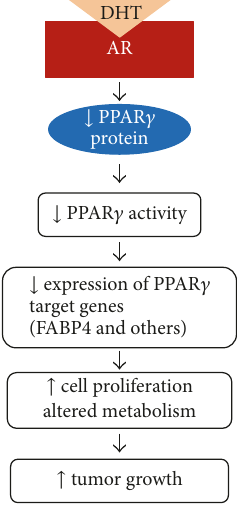
Figure 2: AR regulates PPAR 𝛾 signaling in human prostate can- cers. Data from our laboratory suggest that androgen-induced AR activation produces a net decrease in PPAR 𝛾 protein and PPAR 𝛾 activity in AR-positive castration-sensitive (VCaP) and castration- resistant (C4-2) prostate cancer cells. These decreases in PPAR 𝛾 transcriptional activity result in reduced expression of FABP4 and other PPAR 𝛾 target genes and ultimately alterations in cancer cell proliferation and metabolism that promote tumor